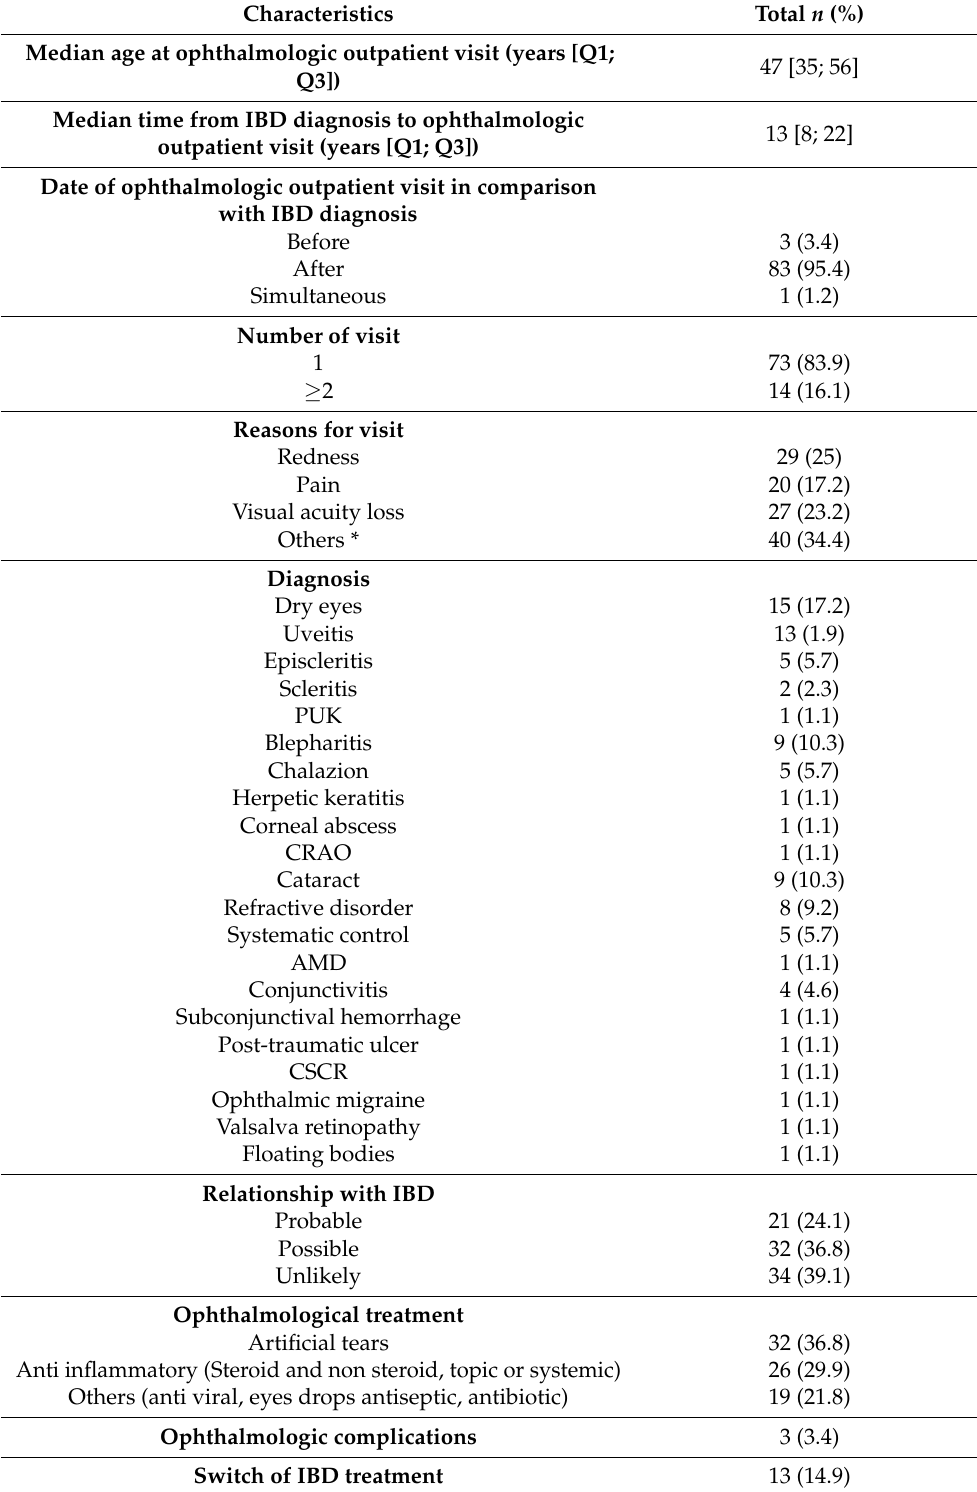
Table 2. Characteristics of ophthalmological